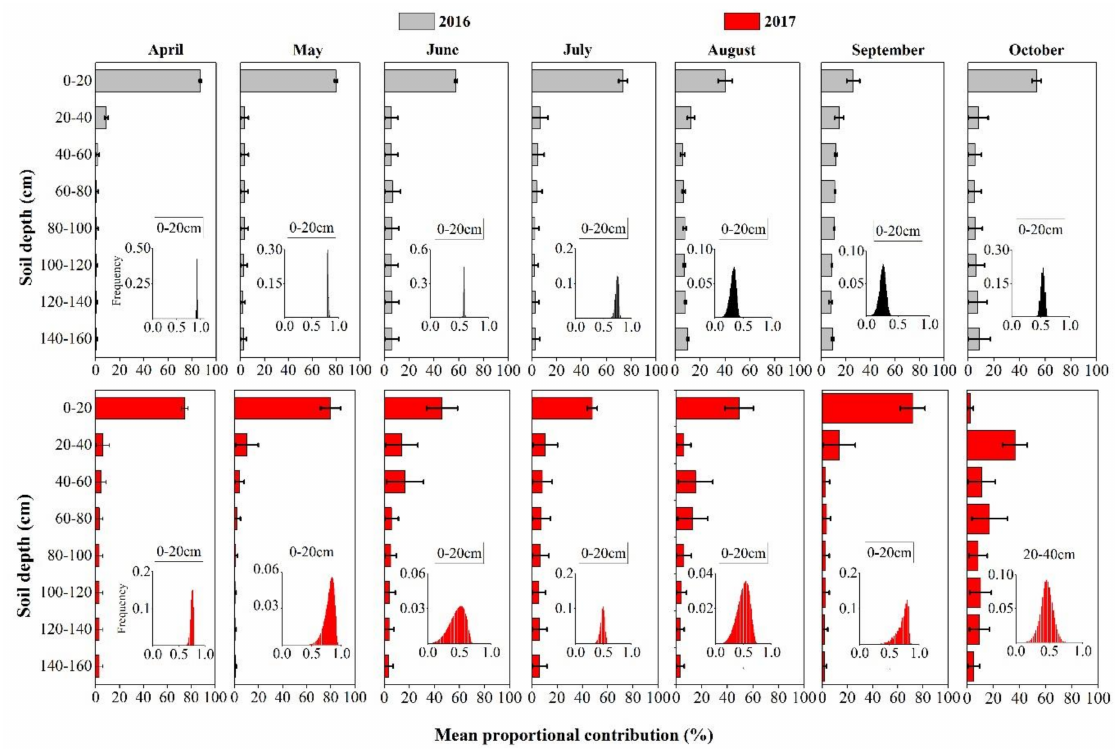
Figure 3. The proportions of soil water contributions at different months in the 2016 and 2017 seasons. The frequency histograms show the estimated ranges of proportional contributions of water from the main soil depth to the total apple water uptake, the x-axis was the proportional contribution from 0 to 1, and the y-axis was the frequency. The error bars are the standard